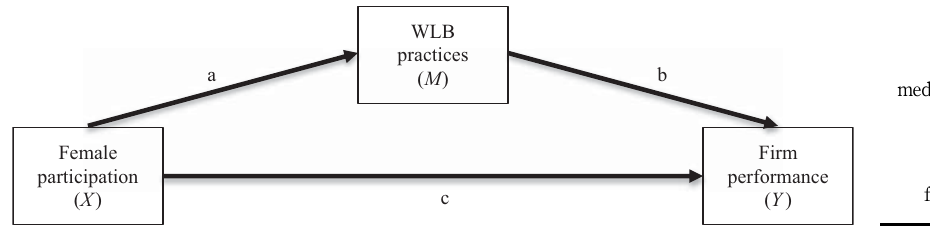
Figure 2. Pathway of a mediation process of the relationship between Female participation in workforce and firm